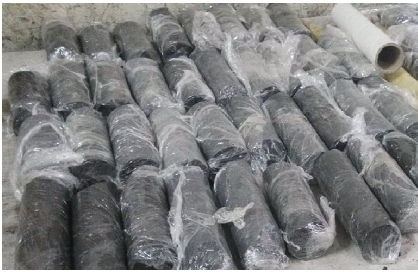
Figure 2: Undisturbed mudstone samples sealed in plastic bags.